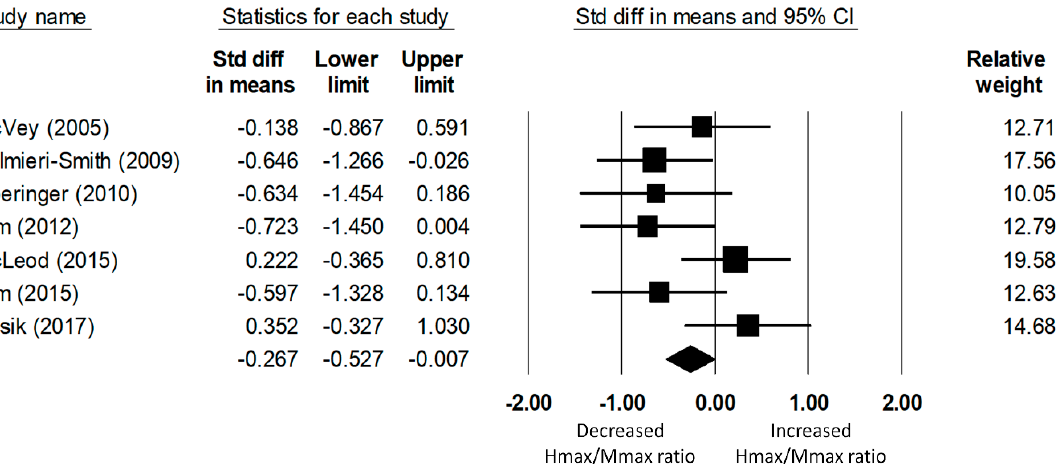
Figure 2. Forest plot illustrating Cohen’s d effect sizes for the soleus Hmax/Mmax ratio between groups with and without CAI and their 95% confidence intervals.